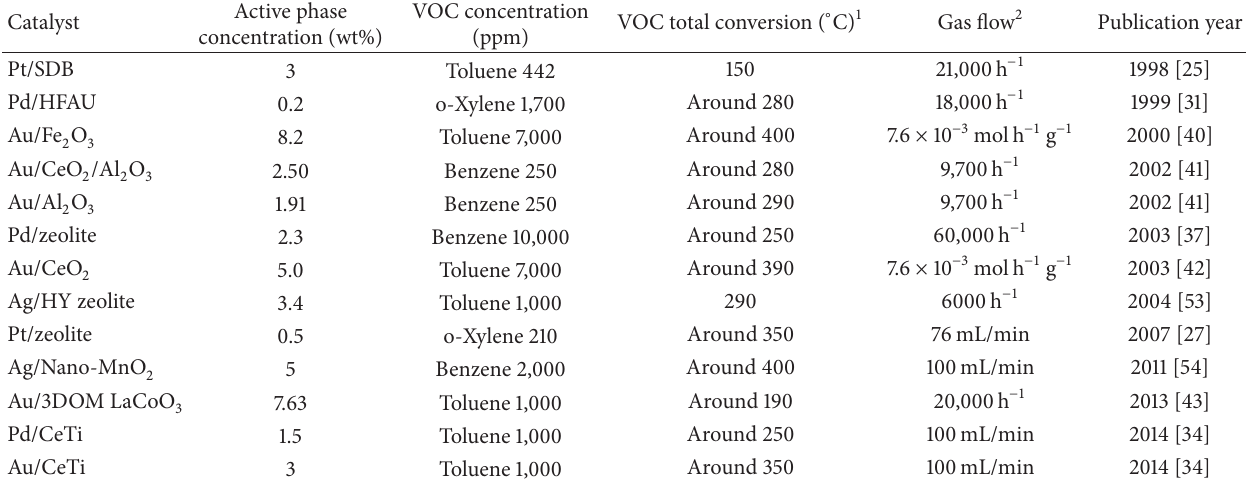
Table 1: Catalytic performance comparison of various noble metals loaded